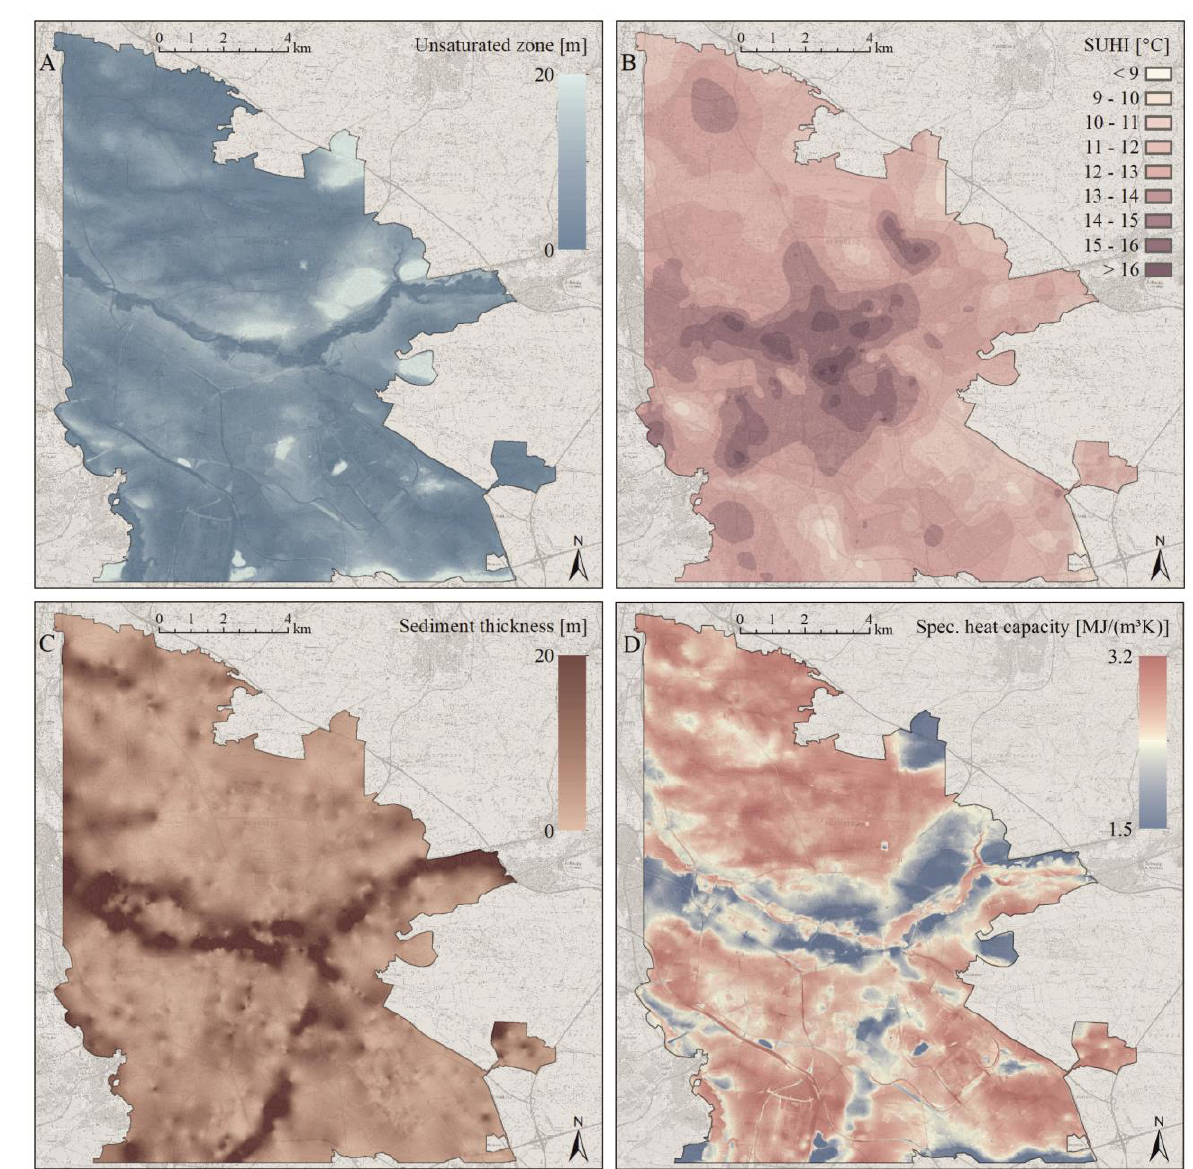
Figure 5. Raster files calculated with GIS about the spatial distribution of ( A ) the thickness of the unsaturated zone in [m], ( B ) the measured groundwater temperatures in [°C] — the SUHI is clearly visible within the city center, ( C ) the thickness of the Quaternary sediments in [m], and ( D ) the mean specific heat capacity in [MJ/(m 3 K)] for the first 0 – 20 m b.g.l. Sources: ( A , B ): Own Measurements and data from Environmental Agency of Nuremberg. ( C ): Data from Bavarian State Office for the Environment, LfU, www-lfu.bayern.de. ( A – D ): Topographic basemap, TK 1:25 000, ATKIS ® , DLM1000; Copyright © Bundesamt für Kartographie und Geodäsie, 2008.